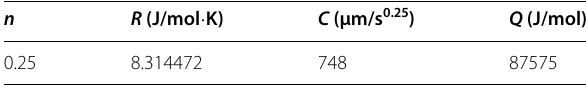
Table 4 Parameters for TGO growth model